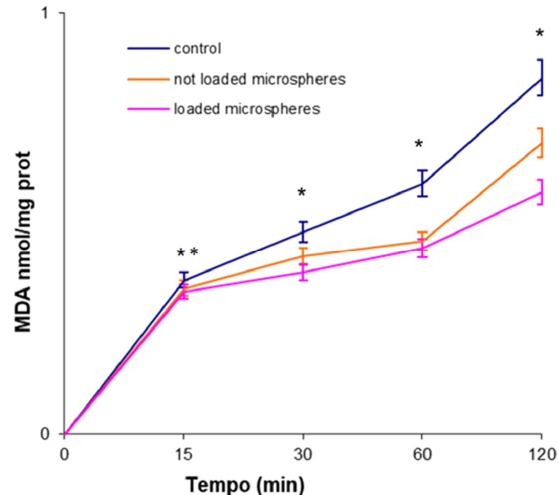
Figure 7. Inhibition of malondialdehyde (MDA) by non-containing and phloretin-containing parti- cles. The results represent the mean ± SD of three separate experiments. Signi fi cance was evaluated by the unpaired t -test. * p < 0.05; ** p <